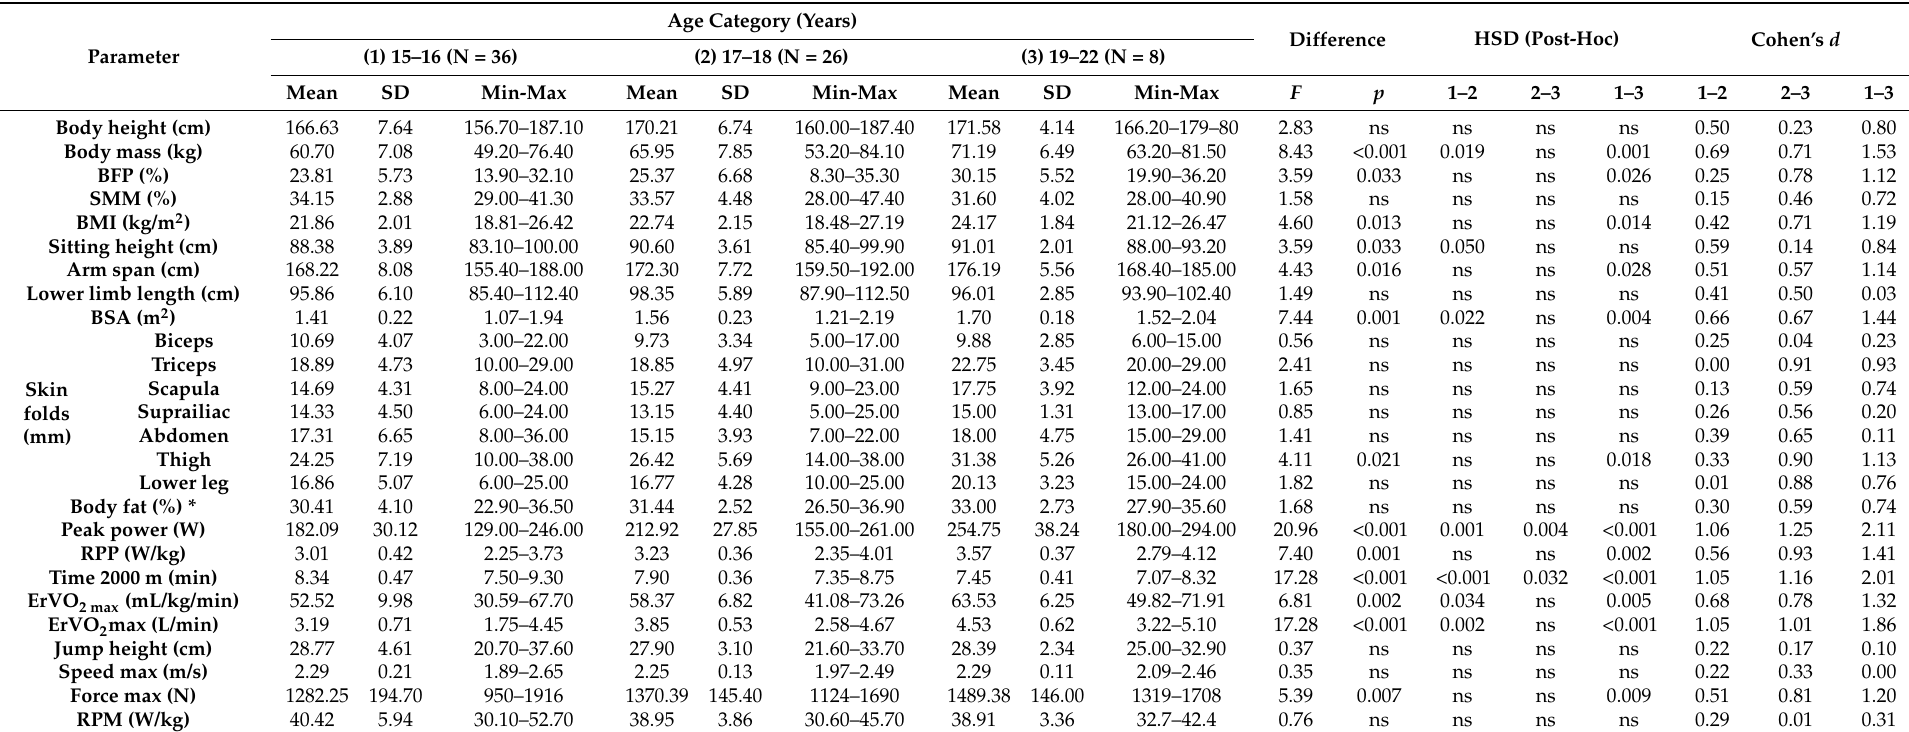
Table 1. Comparison of arithmetic means of women’s anthropometric, physiological and motor parameters depending on the age